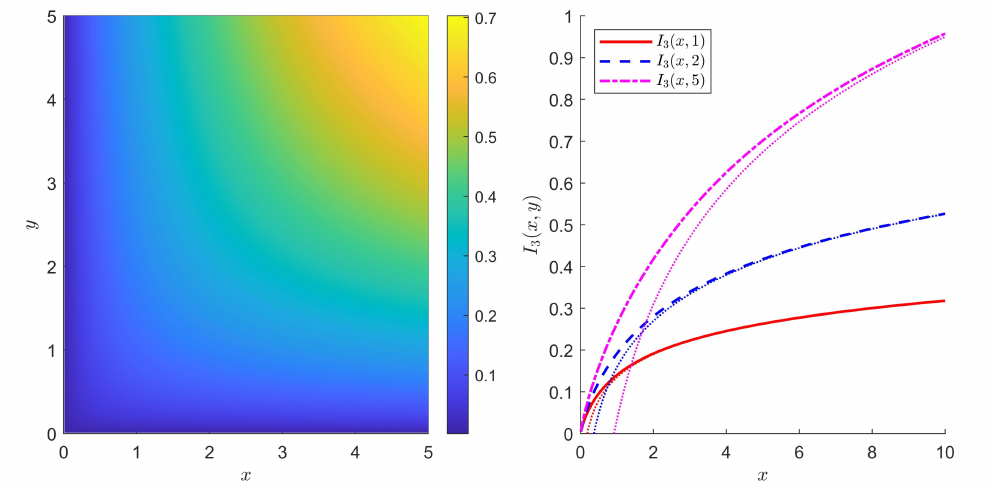
Figure 1. A surface plot of I 3 ( x, y ) , as well as a plot of I 3 ( x, y ) for fixed values of y . We also compare I 3 ( x, y ) at fixed y to the asymptotic behavior at large x denoted by the dotted lines. The